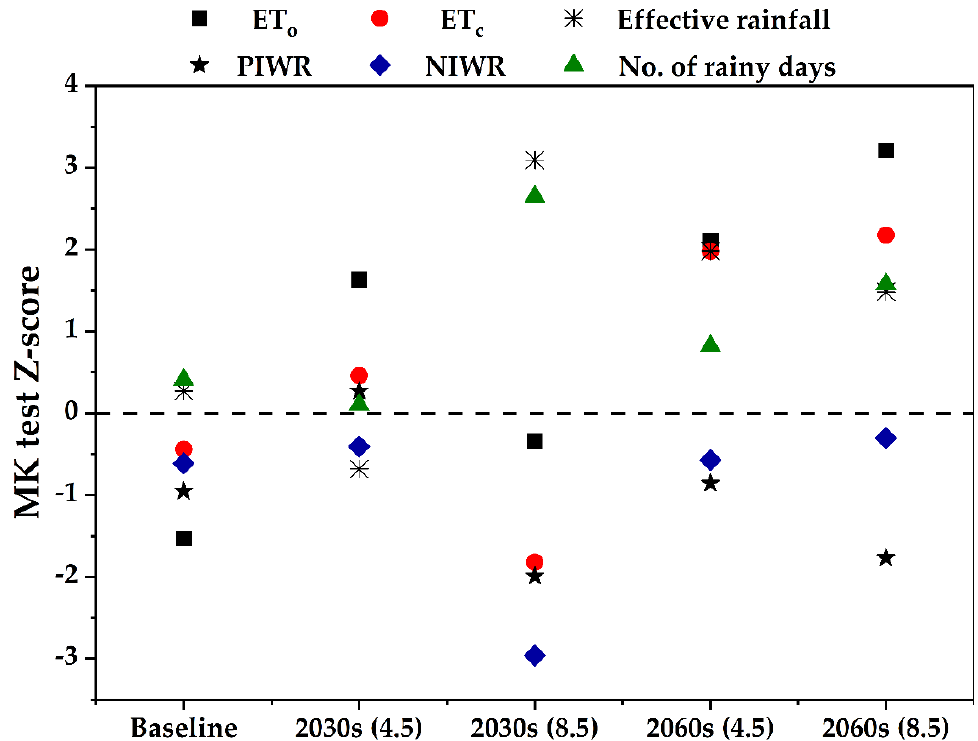
Figure 8. MK test Z-scores for rice seasonal (May–October) cumulative reference evapotranspiration (ET o ), crop evapotranspiration (ET c ), effective rainfall (ER), potential irrigation water requirement (PIWR), net irrigation water requirement (NIWR), and number of rainy days (N) during the baseline (1980–2010), 2030s (2021–2050), and 2060s